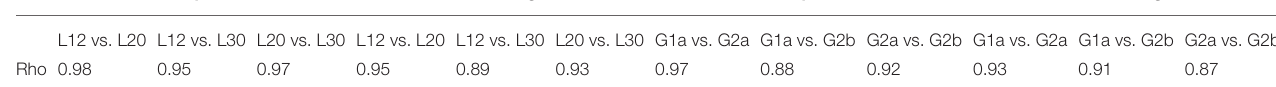
TABLE 1 | Spearman’s correlation coefficients between different BRS-values. G1a L30 Supine Standing Supine Standing